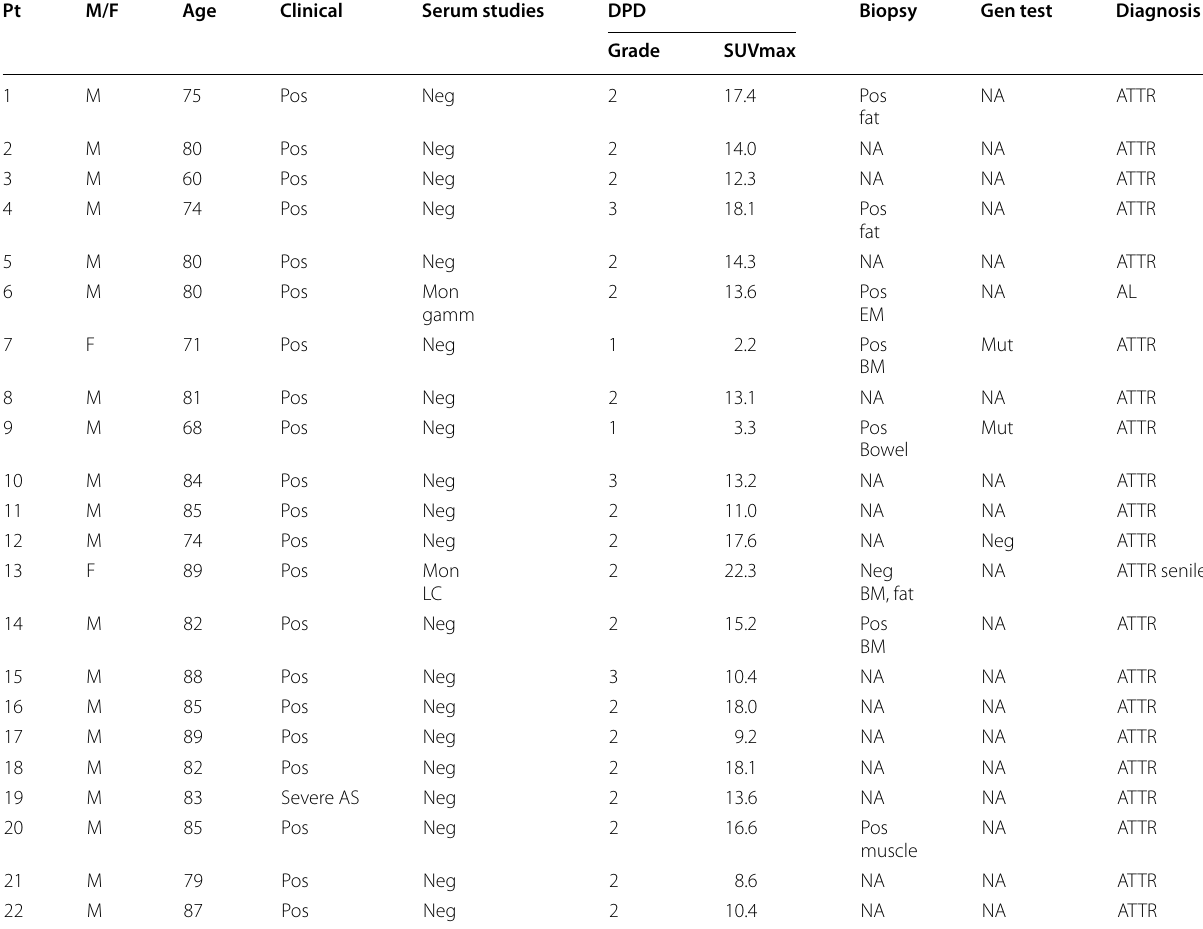
M, male; F, female; Grade, visual; SUVmax, SUV (body weight) max (g/ml); Gen test, genetic testing; pos, positive; neg, negative; ATTR, cardiac transthyretin amyloidosis; AL, light chain amyloidosis; EM, endomyocardial; BM, bone marrow; MUT, mutation Se77Tyr; Mon Gam, monoclonal gammopathy; Mon LC, monoclonal light chains; AS, aortic stenosis Table 2 Summary of visual and quantitative findings